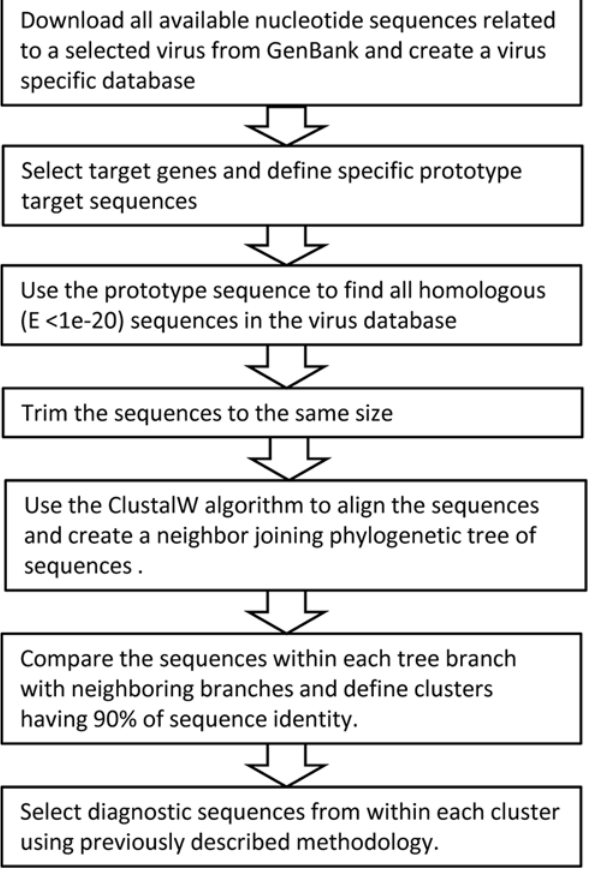
Figure 1. Selection of detector sequences used in RPM-TEI design. The diagram illustrates the main stages of the detector sequence selection process.